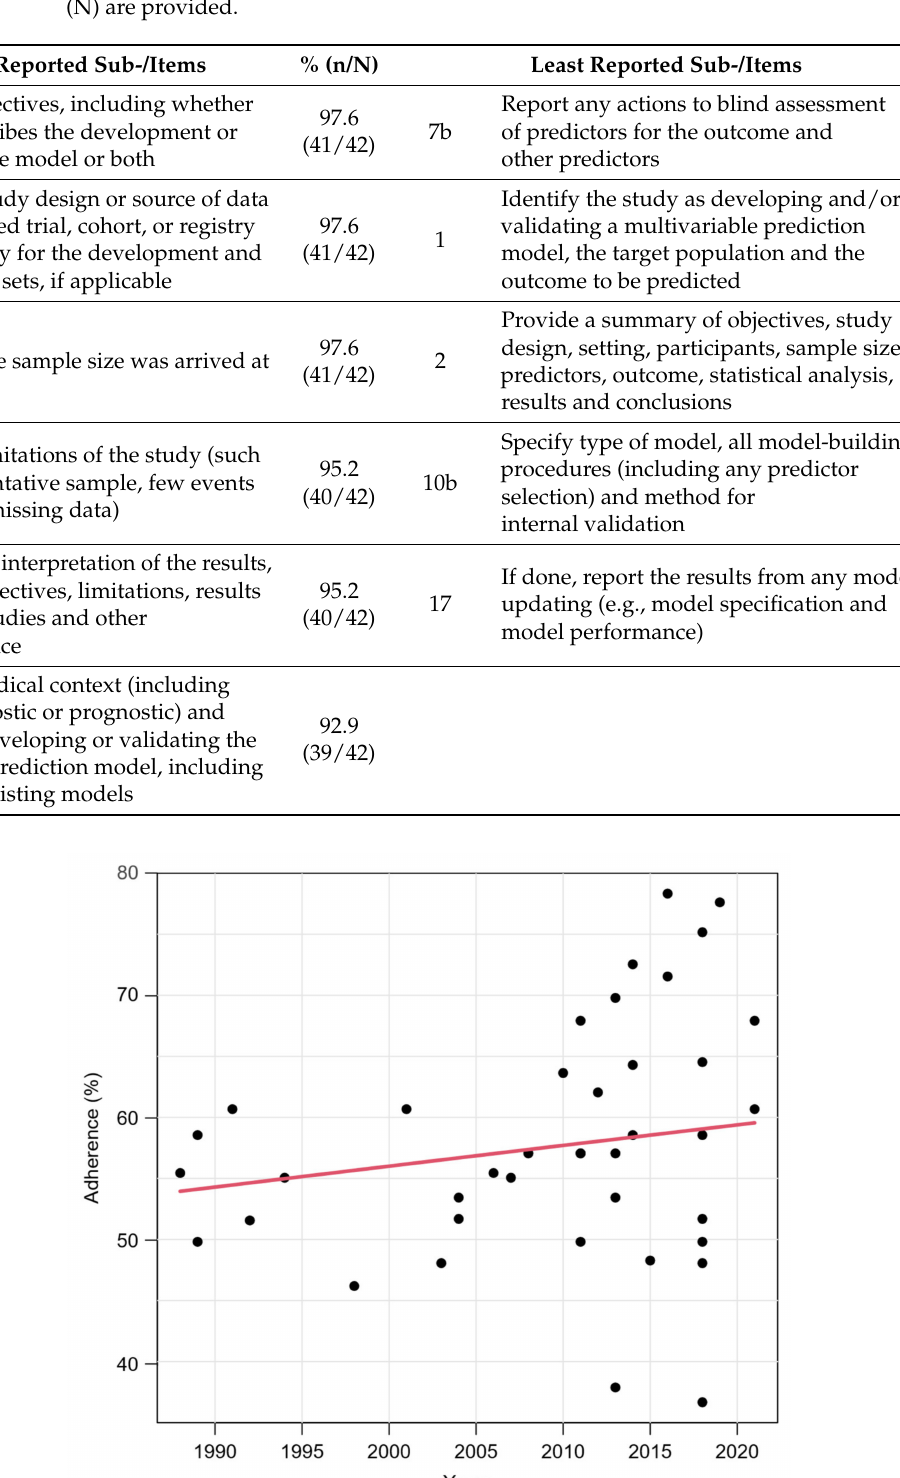
Table 2. TRIPOD components reported in more than 90% and less than 10% of the studies. Complete- ness of reporting of the sub-/items is given as percentage. Additionally, the number of studies that adhered to the specific sub-/item (n) and the number of studies in which the sub-/item is applicable (N) are provided.